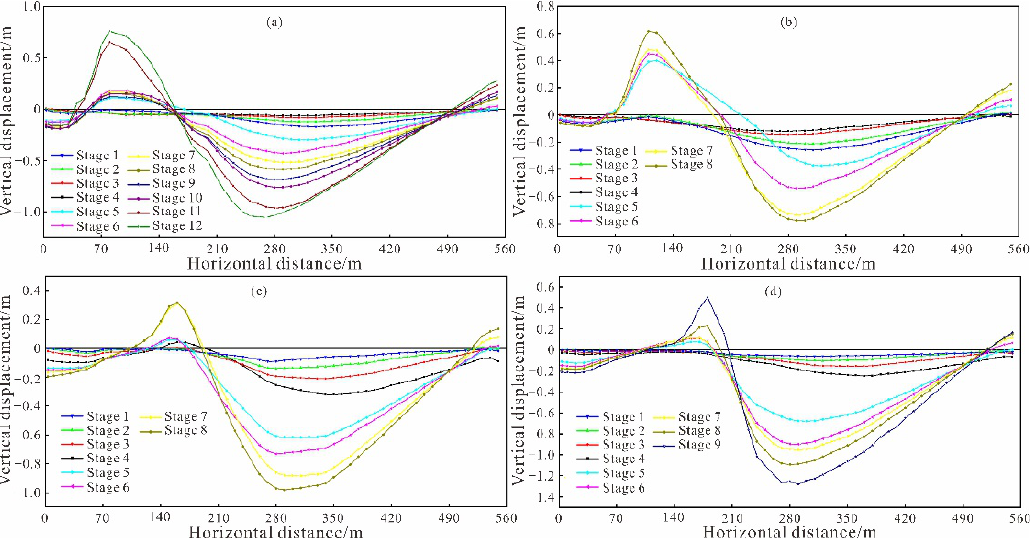
Figure 11. Surface vertical displacement of an ore body with different fault locations. ( a ) Fault location at 30 m in the foot wall; ( b ) fault location at 5 m in the foot wall; ( c ) fault location at 5 m in the hanging wall; ( d ) fault location at 30 m in the hanging wall.